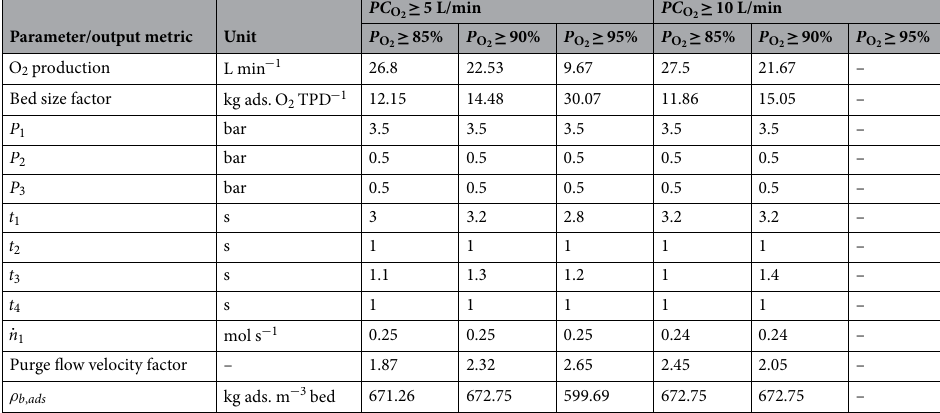
Table 4. Optimization results for PSA and PVSA cycles using LiX and LiLSX zeolites with maximum oxygen recovery, and varying minimum oxygen purity and production